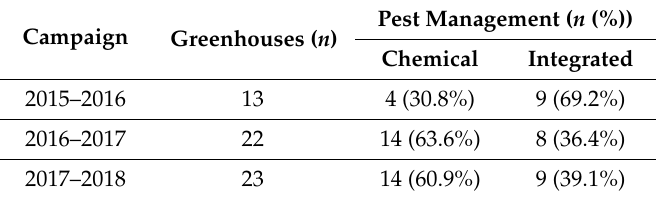
Table 3. Number (% of total) of zucchini crops with chemical or integrated pest control of B. tabaci. Campaign